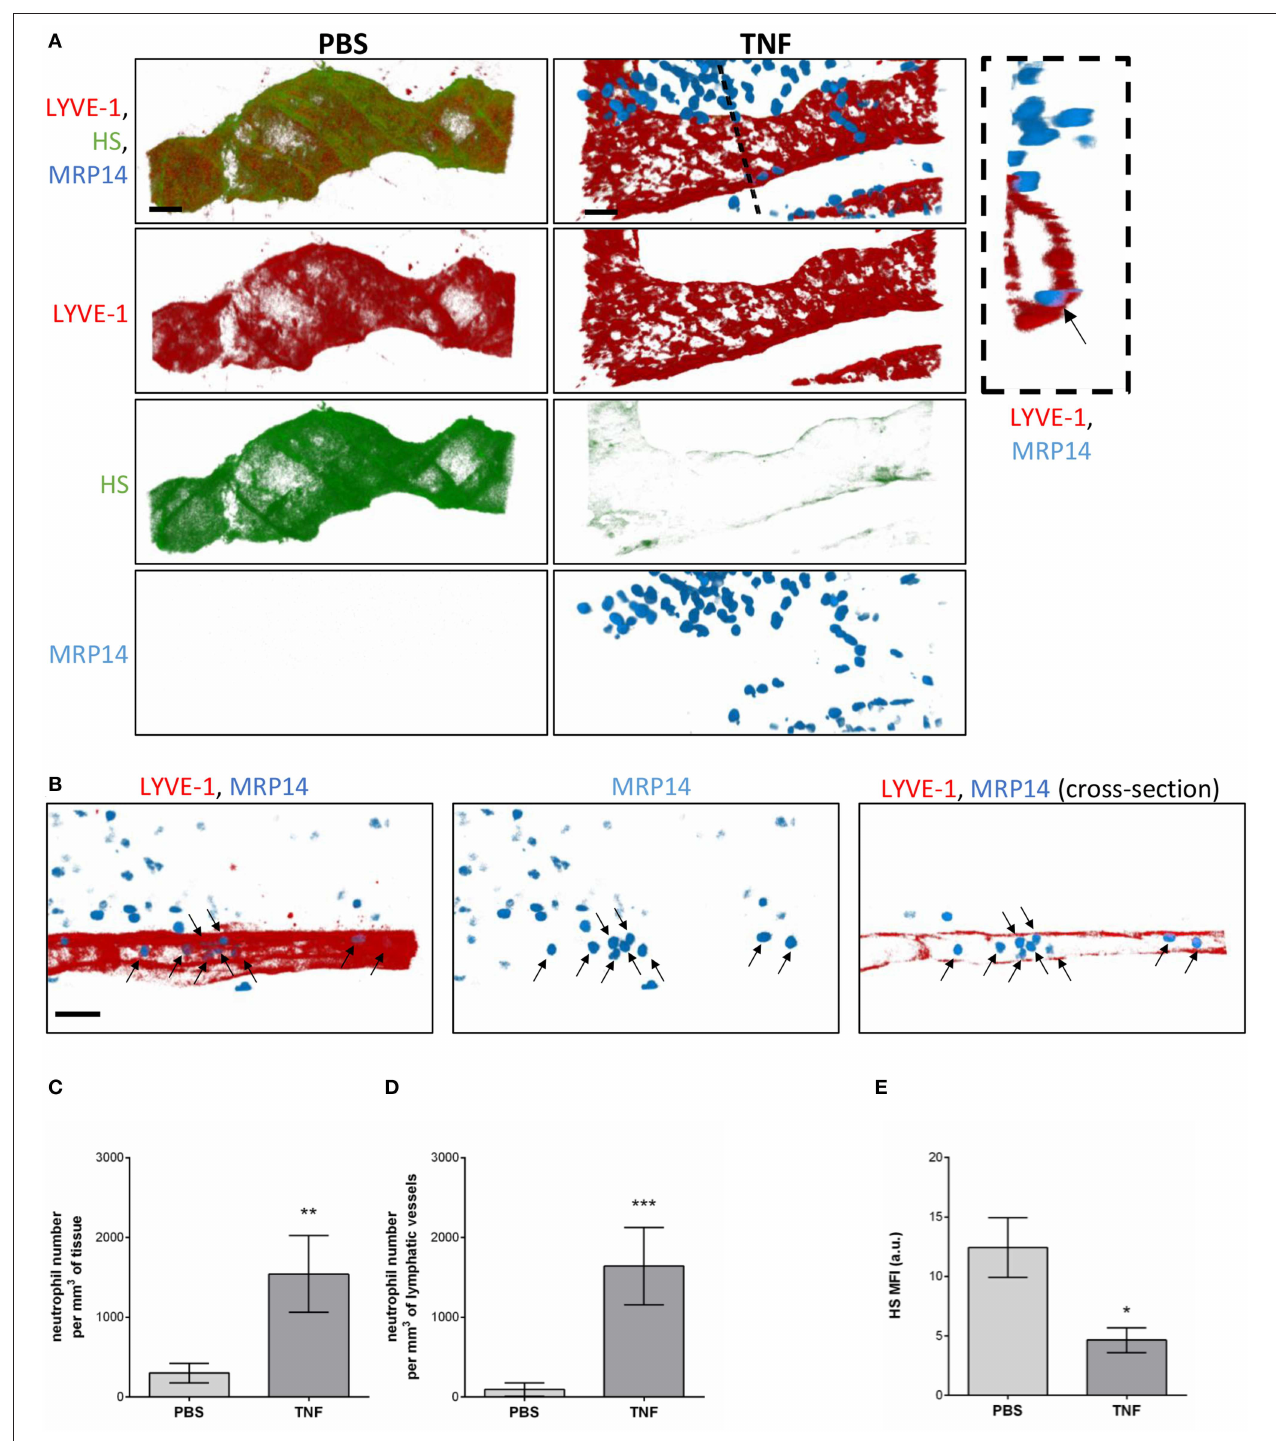
FIGURE 4 | Regulation of Heparan Sulfate expression in the glycocalyx of initial lymphatics and neutrophil migration responses upon inflammation. WT mice were intrascrotally (i.s.) injected with TNF (300 ng) and the inflammatory response was allowed to develop for 16h. Two hours before the end of the inflammation period, mice were further injected i.s with anti-HS (green) and anti-LYVE-1 (red) Abs to visualize the heparan sulfate and lymphatic vasculature, respectively. The cremaster muscles were then harvested, fixed, permeabilized, and immunostained with an anti-MRP14 mAb to visualize the neutrophils (blue). Unstimulated controls received an i.s injection of PBS. (A) Representative 3D-reconstructed confocal images of an initial lymphatic vessel from PBS- (left panels) or TNF- (right panels) stimulated tissues.